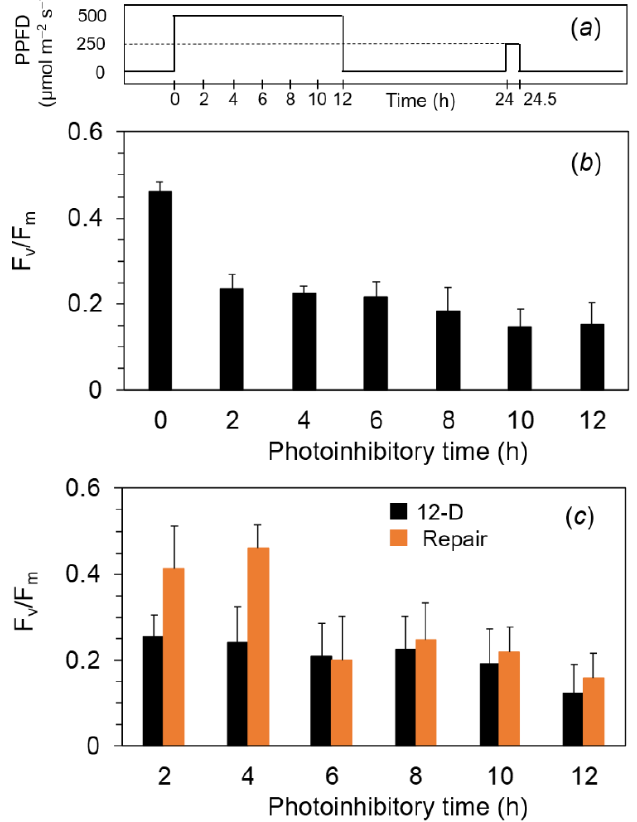
Figure 4. F v /F m after the exposure to continuous high light at 500 μmol m −2 s −1 for 12 h and the subsequent moderate light at 250 μmol m −2 s −1 for 30 min at 2 °C in the marimo filamentous cells. Dark-treated filamentous cells were exposed to white light at 500 μmol m −2 s −1 for up to 12 h at 2 °C on ice ( a ). After the high light for each given time, F v /F m in each cell was measured at 4 °C after the dark treatment for 30 min ( b ) and 12 h (black bar in c). The cells after the 12 h dark treatment were irradiated by the white light at 250 μmol m −2 s −1 used as the repair light for 30 min at 2 °C on ice, and then F v /F m was measured after the dark treatment for 30 min ( c ) (orange bar in c). Measurements were taken in the cold room (40 Pa CO 2 , 21 kPa O 2 , at 4 °C). The values represent the means ± SD ( n =